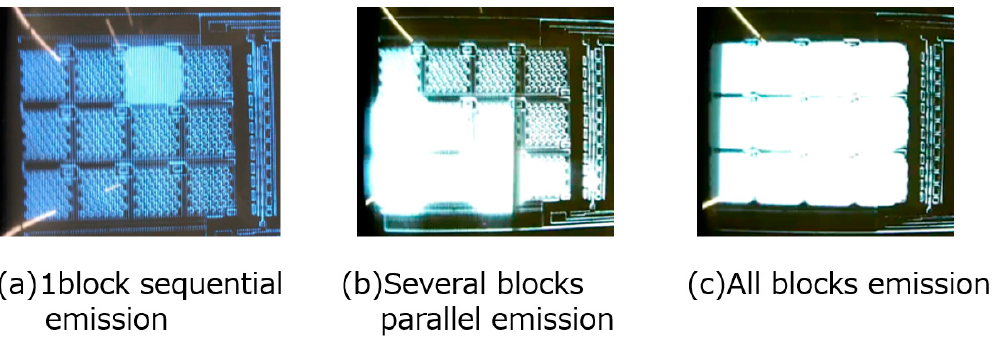
Figure 7. SS-VCSEL emission modes: ( a ) one-block sequential emission, ( b ) emission from several blocks in parallel, and ( c ) all-blocks emission.